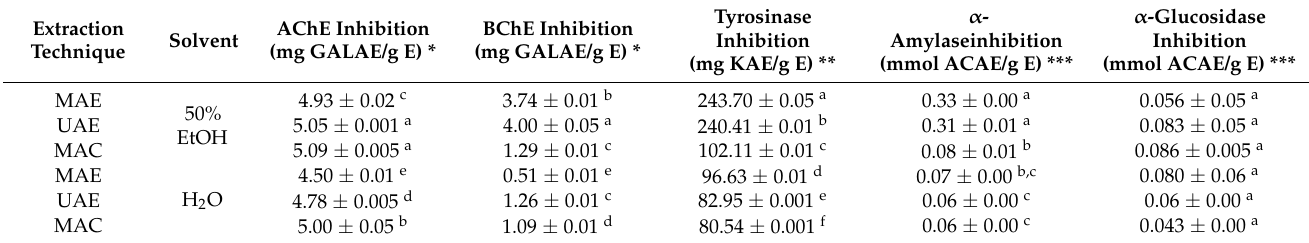
Table 4. Enzyme inhibitor capability of fresh fruits of elderberry